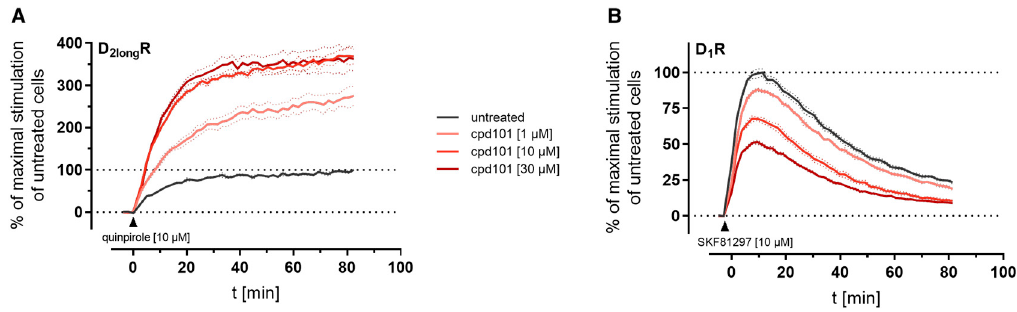
Figure 8. Impact of the specific GRK2 / 3 inhibitor cpd101 on the kinetics of β -arrestin2 recruitment to the D 2long R ( A ) and the D 1 R ( B ). Data represent means ± SEM from three independent experiments, each performed in triplicate.